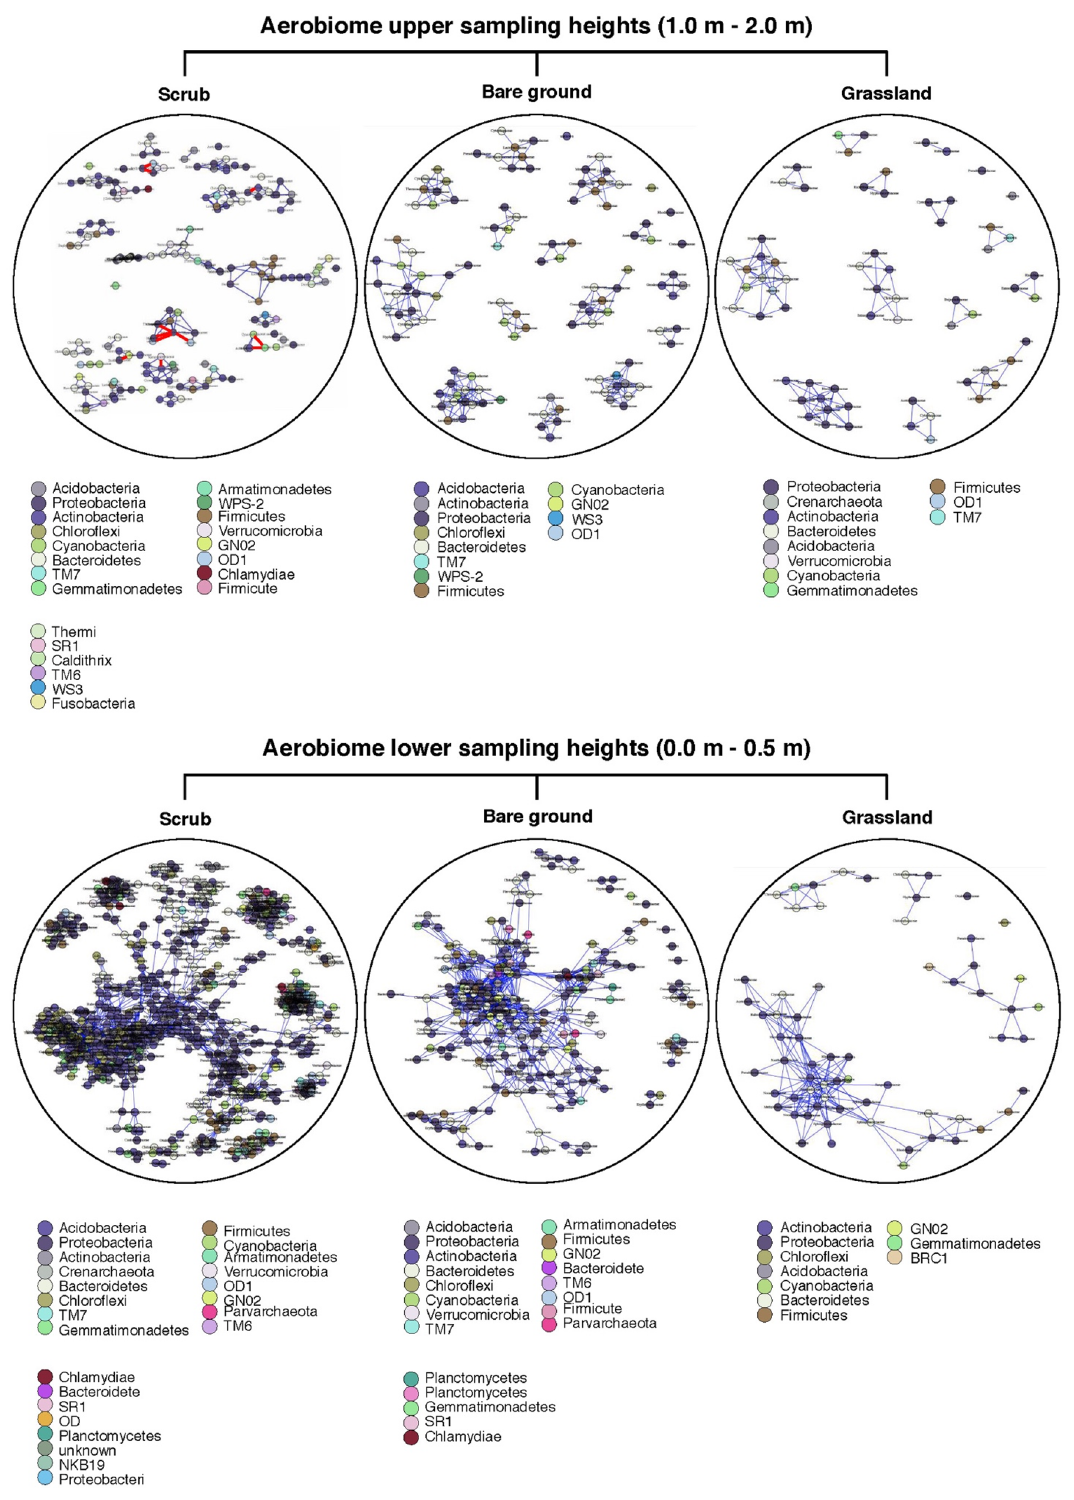
Figure 4. Association networks of bacterial OTUs for two vertical stratifications: 1.0–2.0 m (top panel) and 0.0–0.5 m (bottom panel). Node colour represents phylum, and node are labelled at the family level. Blue links represent positive associations, and red links represent negative